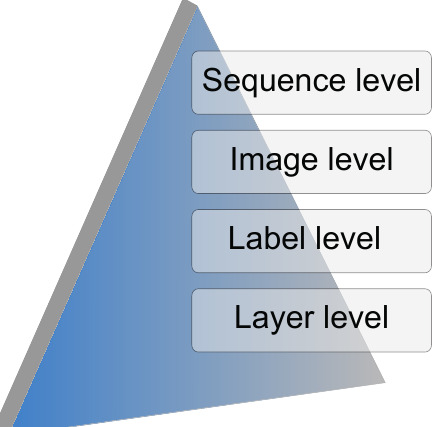
Figure 1. Hierarchy levels in the architecture of the Tool for Semiautomatic Labeling